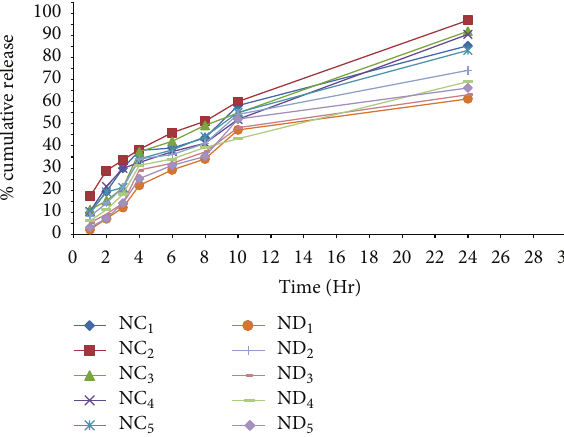
Figure 5: Comparative encapsulation efficiency of various series of niosomal formulation at ratio 1: 1:1 (drug: cholesterol :surfactant).